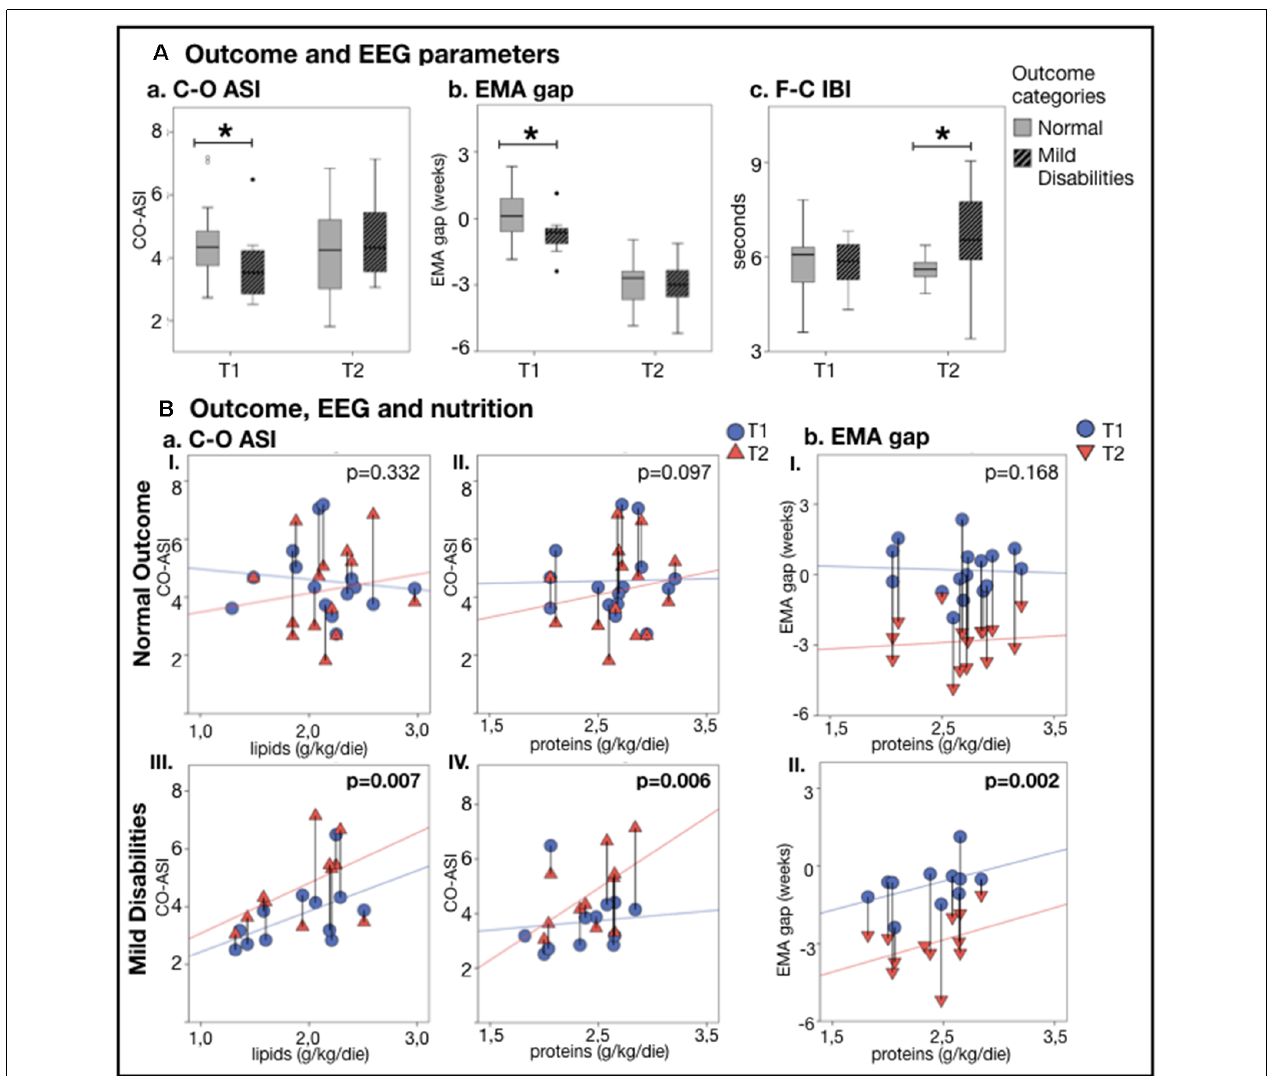
FIGURE 4 | EEG metrics and nutrition vs. neurodevelopmental outcome at 24 months. (A) Comparison of outcome groups shows that a typically developing infant has higher C-O ASI ( p = 0.045; Aa ) and lower EMA gap ( p = 0.030; Ab ) at the first recording (T1), while those with minor developmental disabilities had a longer F-C IBI ( p = 0.009; Ac ) at the second recording (T2) (* p < 0.05). (B) Change in EEG metrics vs. nutrition shows that babies with mild disabilities presented with a stronger increase in C-O ASI and lower EMA gap as a function of lipids ( aI typical outcome group, aIII atypical outcome group) and proteins ( aII,bI typical outcome group, aIV,bII atypical outcome group). The effect of nutrition on EEG features lessened and lost significance by considering only who developed typically. Vertical lines connect individuals’ EEG metrics from T1 and T2; p -values refer to GEE models that account for PMA at both